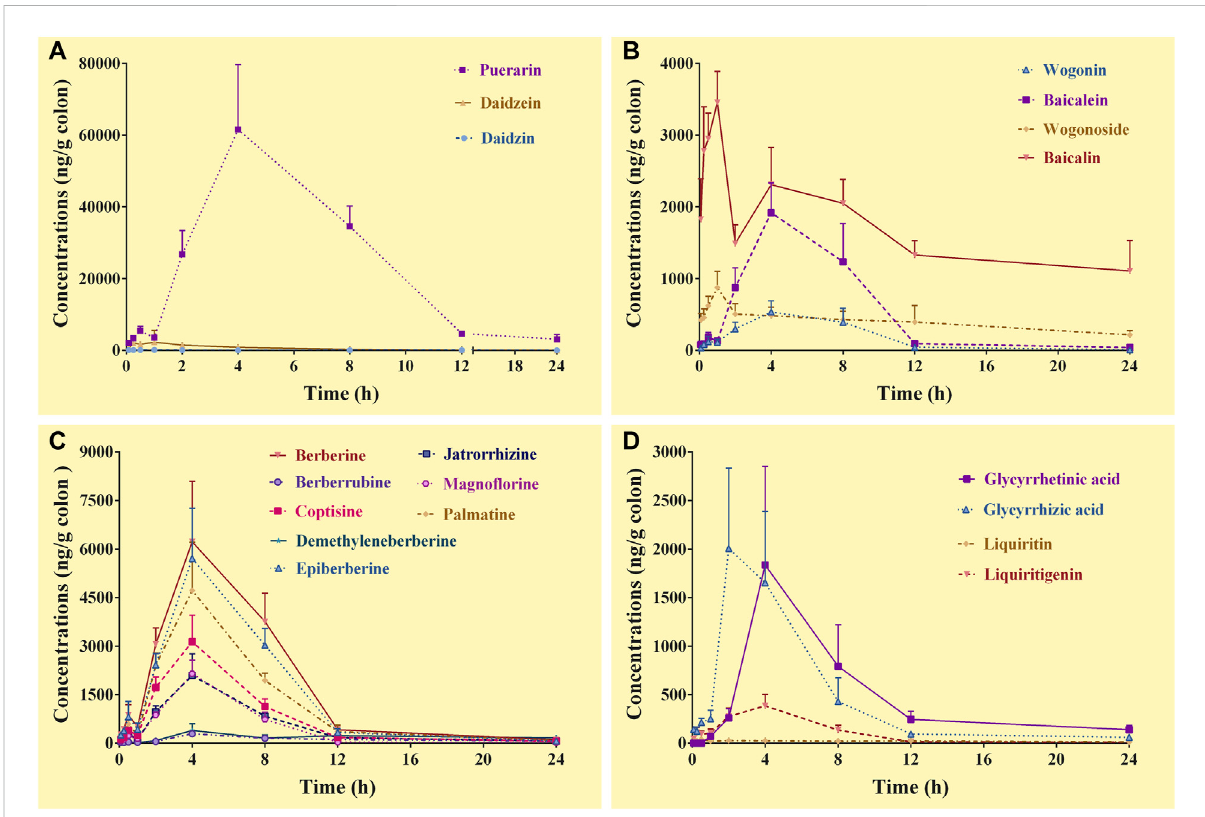
FIGURE 4 Concentration-time curves of the constituents of Gegen - Qinlian decoction in the colons of the mice received the oral Gegen - Qinlian decoction at the dosage of 6.1 g/kg (mean ± SD, n = 6). (A) , constituents derived from Puerariae Lobatae Radix ; (B) , constituents derived from Scutellariae Radix ; (C) , constituents derived from Coptidis Rhizoma ; (D) , constituents derived from Glycyrrhizae Radix Et Rhizoma Praeparata Cum Melle